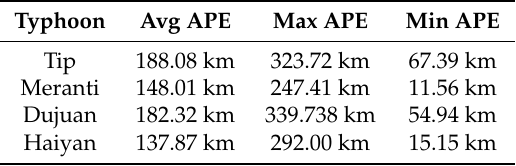
Table 7. Avg APE, max APE, and min APE results of four typhoons in the 72 h